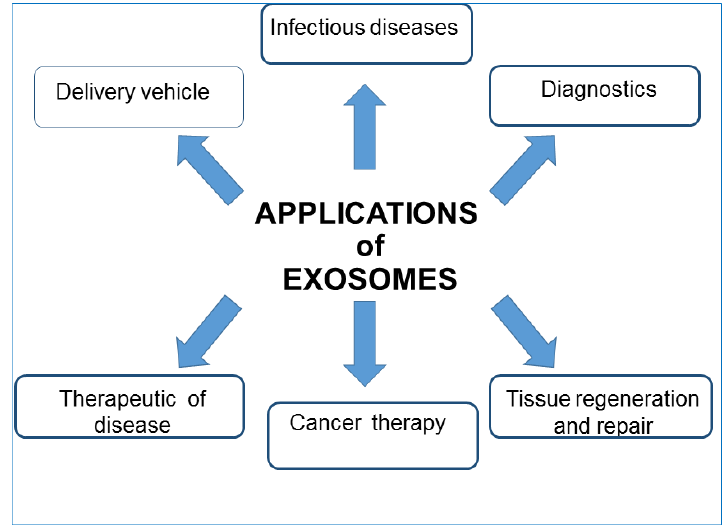
Figure 5. Some of the major uses of exosomes in clinical development. Exosomes affect various aspects of cell biology and can find employment in different fields of nanomedicine.